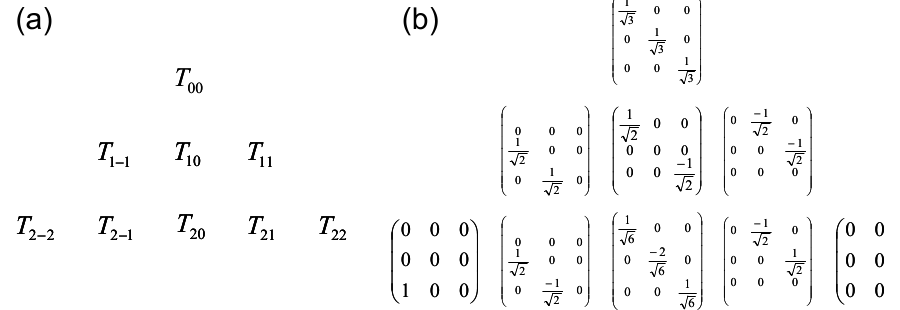
Figure A2. Complete orthogonal basis set (nine elements) describing the evolution of the spin I = 1: ( a ) symbolic representation T ij ; ( b ) explicit matrix representation of irreducible tensor